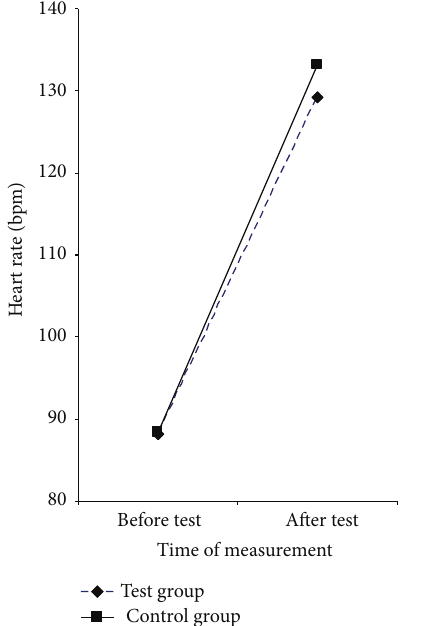
Figure 1: Presentation of the groups studied in relation to the value of the heart rate before and after the test.